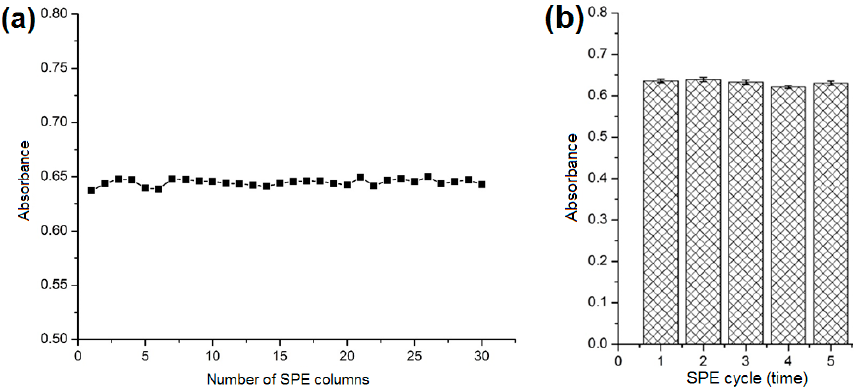
Figure 8. ( a ) Reproducibility and ( b ) reusability of the SPE column.